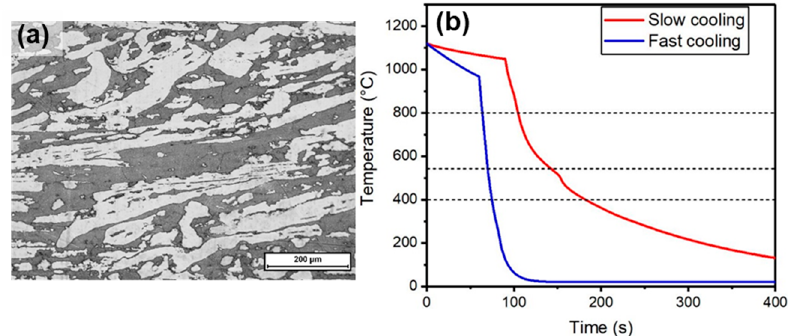
Figure 1. ( a ) Light optical micrograph of SDSS 2507 after etching using a modified Beraha II solution (100 mL water, 50 mL HCl, and 0.5 g K 2 S 2 O 5 ): the scale bar is 200 μ m; ( b ) the cooling cycles imposed on the two different samples prior to ageing. Table 2. Cooling rates of the investigated samples at different temperature ranges.